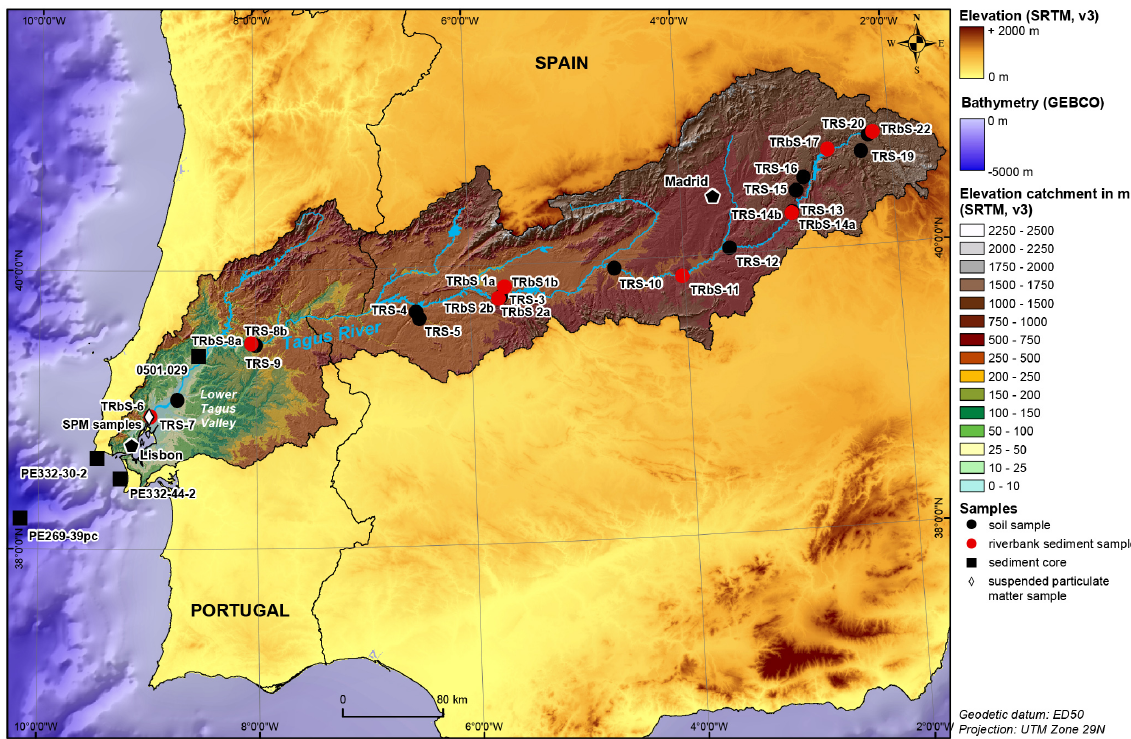
Figure 1. The location of the study area on the Iberian Peninsula with the stations where the four sediment cores were sampled (indicated by black squares) along a transect from the Tagus River to off the Portuguese continental margin, as well as the river SPM sampling site (indicated by a white diamond), riverbank sediment sampling sites (indicated by red circles), and soil sampling sites (indicated by black circles). The river SPM, riverbank sediments, and soil samples were all collected in a previous study. Digital elevation data are from Jarvis et al. (2006) and bathymetry from IOC-IHO-BODC